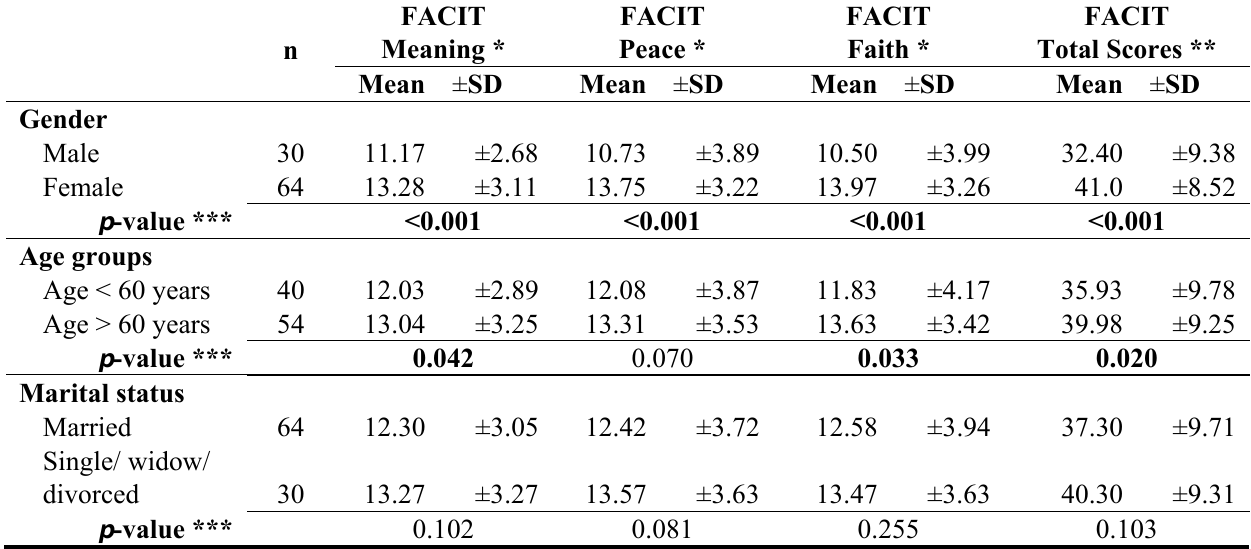
Table 2. Functional Assessment of Chronic Illness Therapy–Spiritual Well-Being (FACIT) domains and total scores by patient demographic